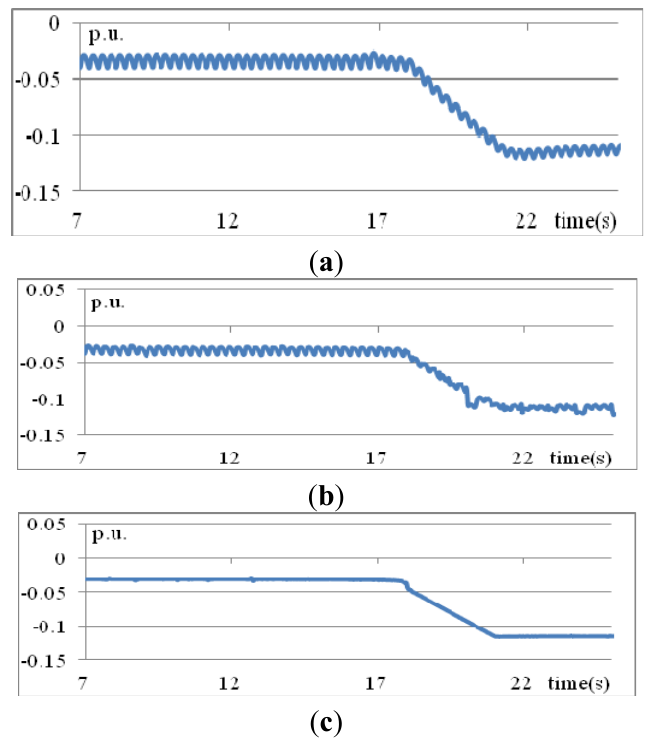
Figure 11. MVARs from STATCOM obtained using three methods: ( a ) traditional PID; ( b ) T1 fuzzy rules; and ( c ) IT2 fuzzy rules (Scenario 2).